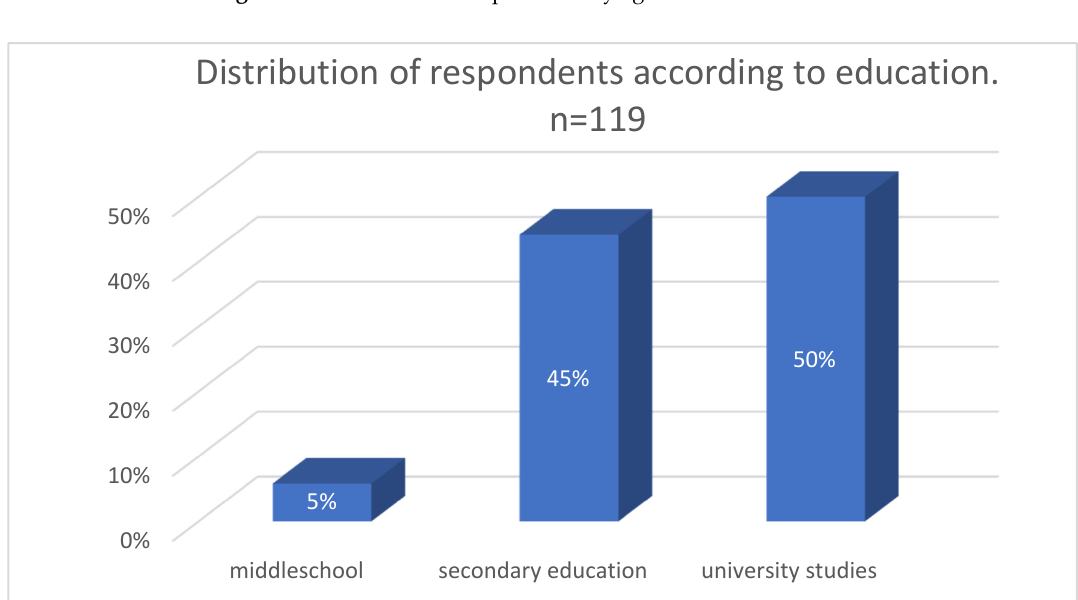
Figure 1. Distribution of respondents by age.